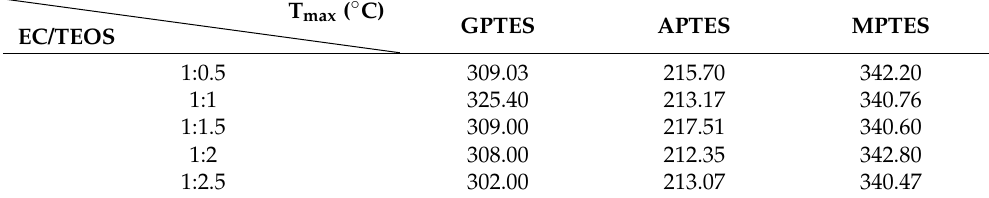
Figure 2. ( a ) TG curves (from 30 °C to 600 °C) of GCSM; ( b ) TG curves (from 30 °C to 600 °C) of ACSM; ( c ) TG curves (from 30 °C to 600 °C) of MCSM. Table 1. T max of the wall material at different EC/TEOS addition